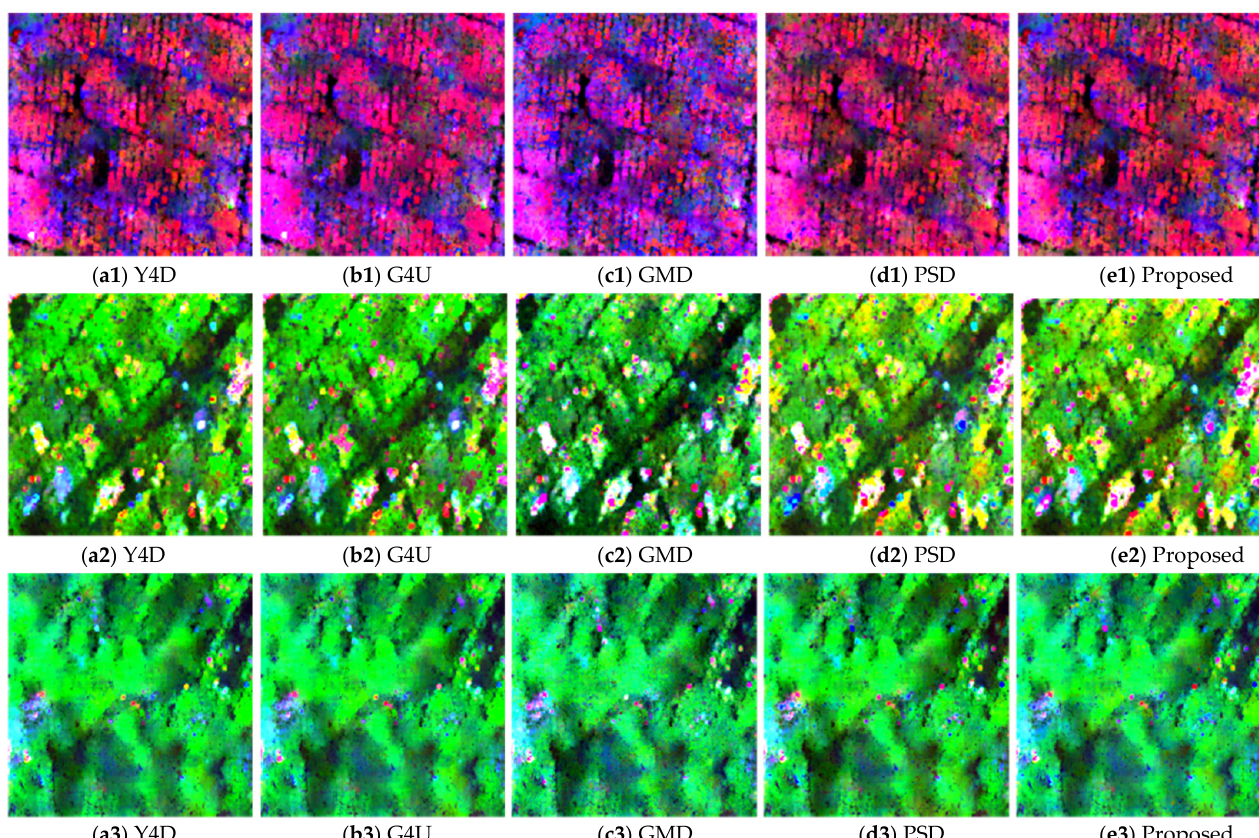
Figure 7. Decomposition results of patches (A,B,C) selected from spaceborne C-band RadarSat-2 data. ( a1 – e1 ) are the decomposition results over urban area (A). ( a2 – e2 ) are the results of oriented urban area (B). ( a3 – e3 ) are the results of forests area (C). The images are colored by Pd ( red), Pv (green), and Ps